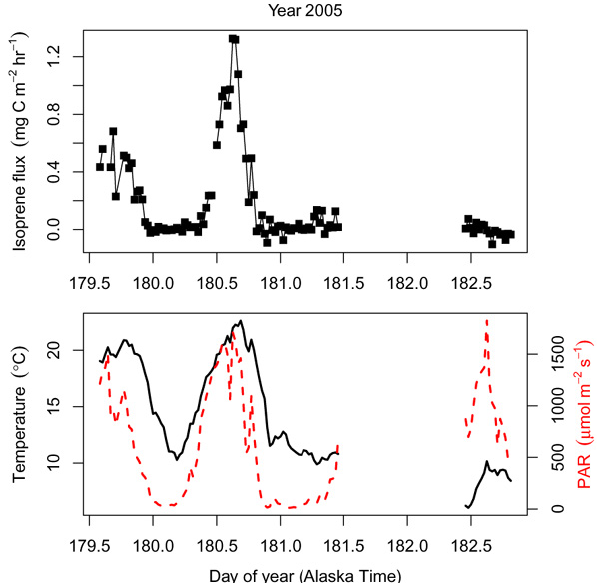
Fig. 3. Ecosystem-level fluxes of isoprene (top panel) and tempera- ture (black, solid line) and photosynthetically active radiation (red, dashed line) for 2005 (bottom panel). The system was not run from day 181 to 192 since light and temperature were suppressed by ground